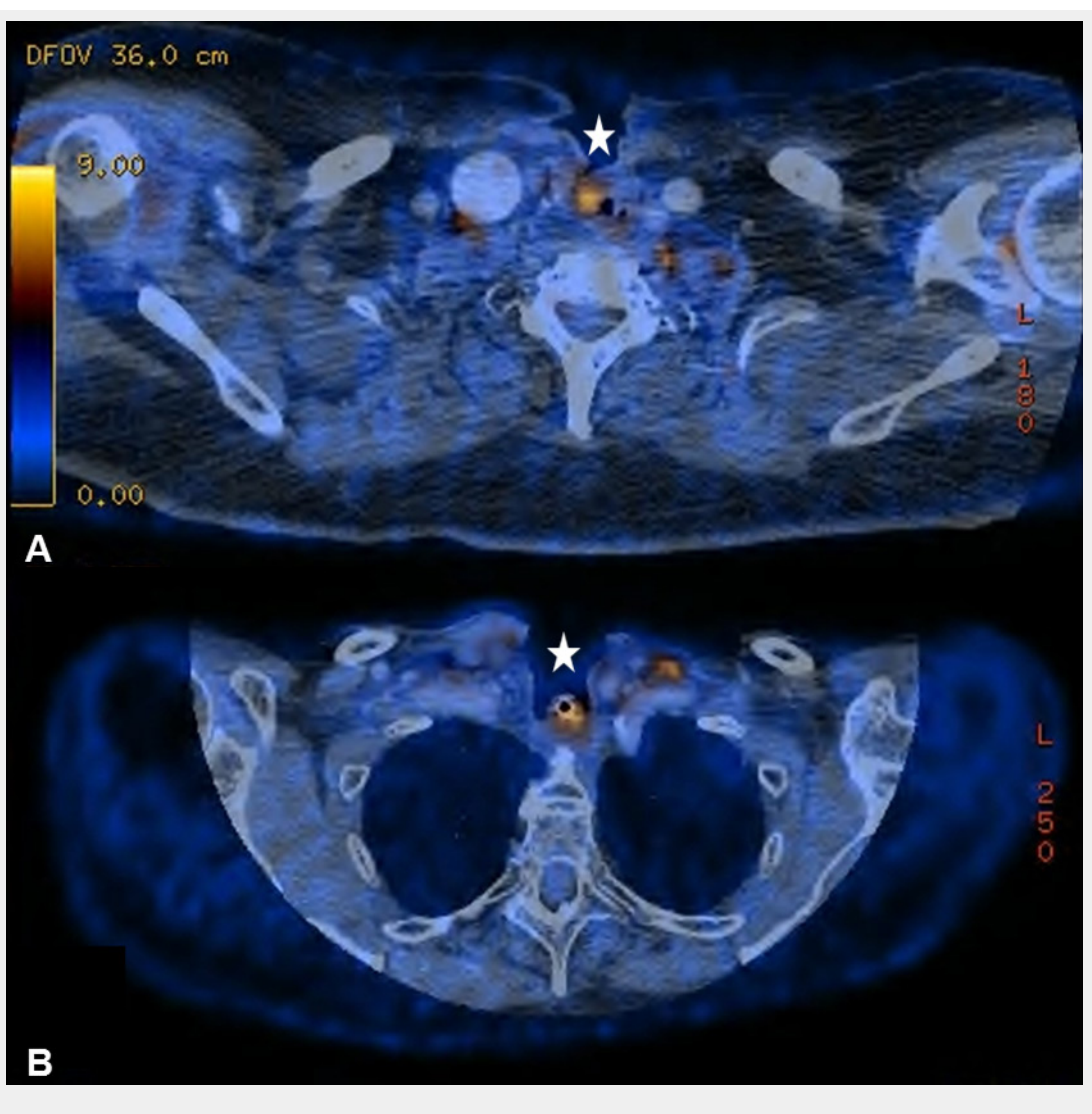
(A) Increased uptake around inserted voice prosthesis in a 74-year old patient with a past medical history of total laryngectomy and radiation therapy (RT) due to a transglottic larynx carcinoma. (B) Seventy-one year old patient after total laryngectomy, partial thyroidectomy and RT with increased uptake around the